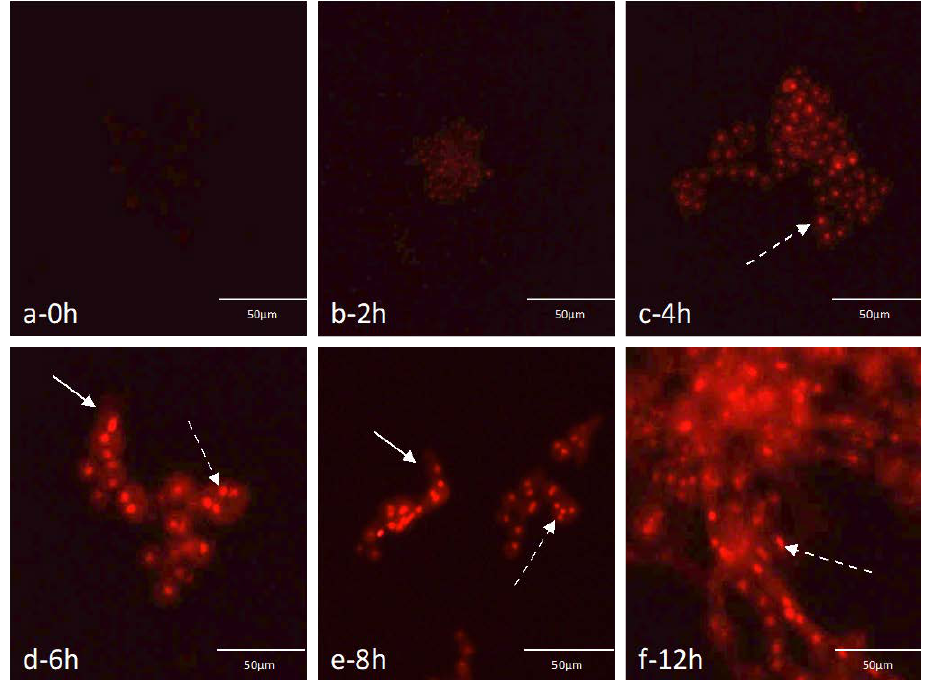
Figure 2. Epifluorescence microscope visualization of A. fumigatus MUM 07.05 germination along time, in PYG medium with FUM274. A very faint fluorescence signal can be observed at 0 h ( a ); signal was still weak at 2 h and 4 h ( b , c ); At 6 h, 8 h, and 12 h the signal intensity increases substantially ( d – f ). It can be noticed that conidia starts swelling at 4 h, and that partial germination occurs at 6 h and 8 h (filled arrows), whereas full germination is achieved at 12 h. In certain locations inside the cells the fluorescence signal is more intense (dotted arrows). All images were obtained with an equal exposure time.